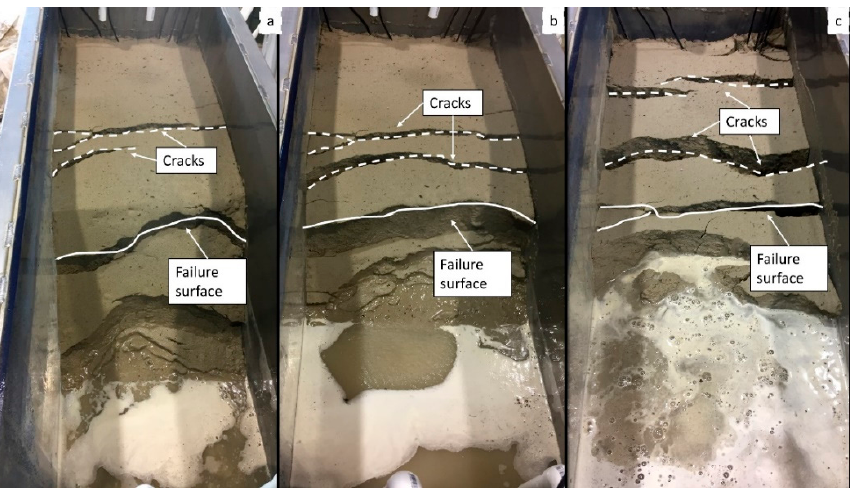
Figure 6. Typical examples of the progressive slope failure observed in the flume experiments with rainfall intensities of 70 mm/h ( a , b ) and 100 mm/h ( c ).